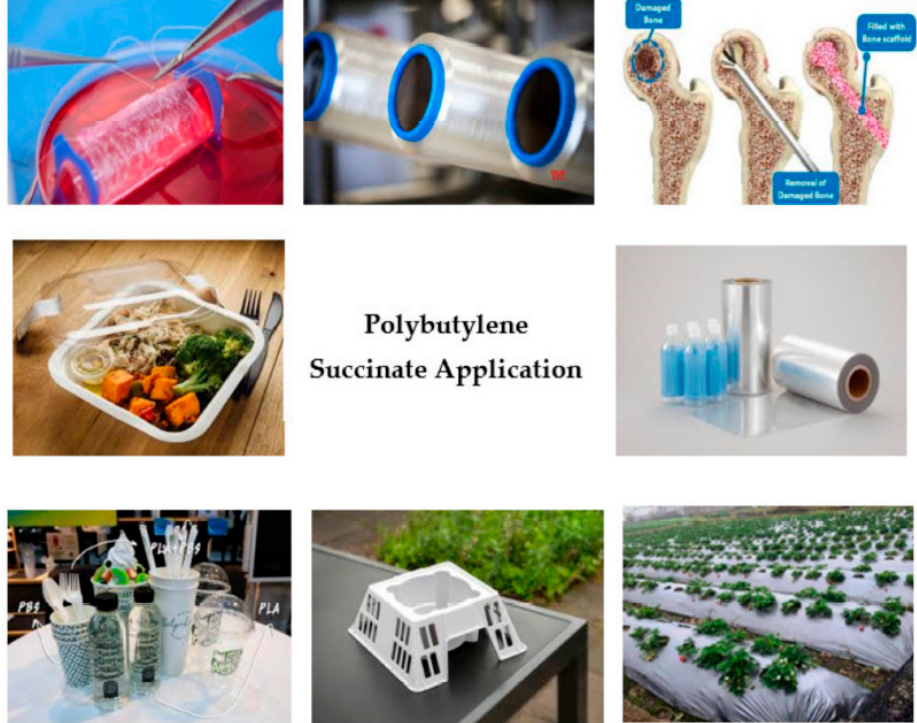
Figure 12. PBS applications